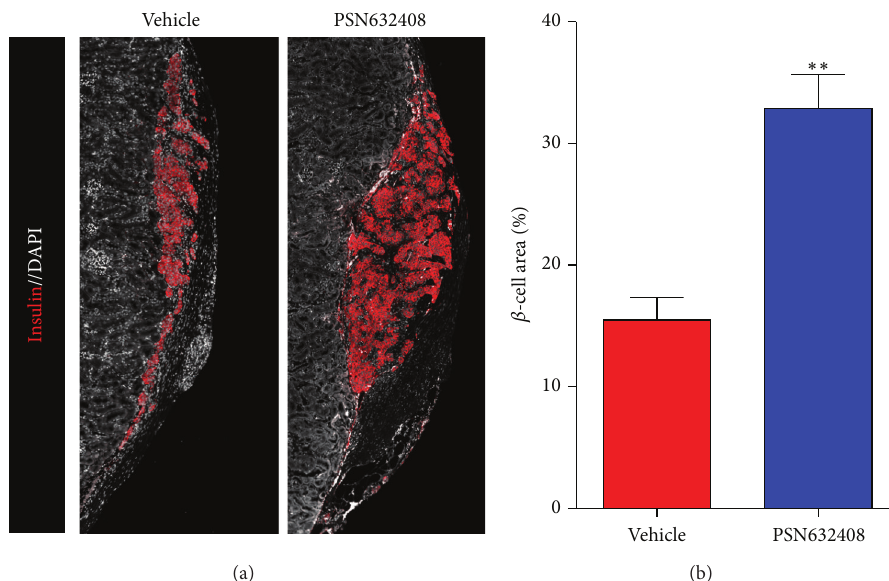
Figure 3: (a) Immunofluorescent staining for insulin (red color) and DAPI (white color) in human islet grafts from the same donor under kidney capsules in PSN632408- and vehicle-treated mice at 4 weeks after transplantation. (b) Percentage of 𝛽 -cell area in islet grafts. 𝛽 -cell area in islet grafts of PSN632408-treated mice ( 𝑛 = 6 ) was significantly increased compared with vehicle-treated mice ( 𝑛 = 3 ) ( ∗∗ 𝑃 < 0.001